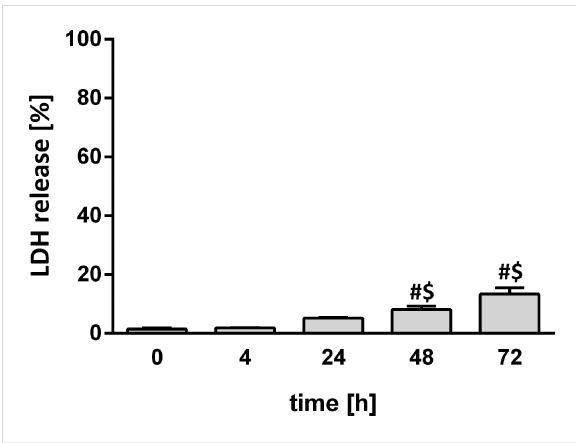
Figure 1: Cell viability as measured by LDH release in PCLS culture medium at 0, 4, 24, 48, and 72 h after preparation of PCLS. Results were calculated as percentage of the positive control (Triton X-100- lysed PCLS) (n = 5; # p < 0.05 vs 0 h; $ p < 0.05 vs 4 h determined by ANOVA on ranks with post hoc Tukey test).